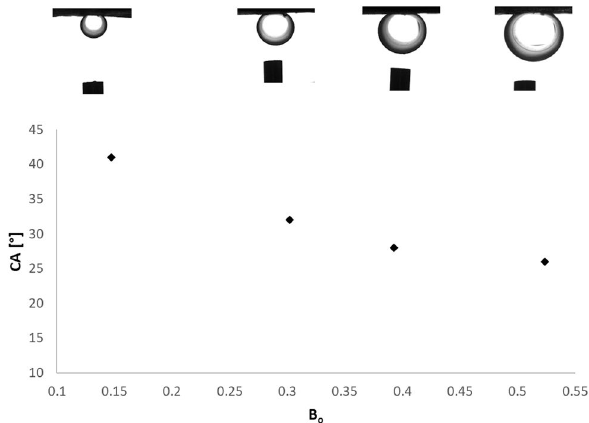
Fig. 5 Contact angle as a function of the bond number as calcu- lated based on the baseline diameter at 10 MPa and 60 °C